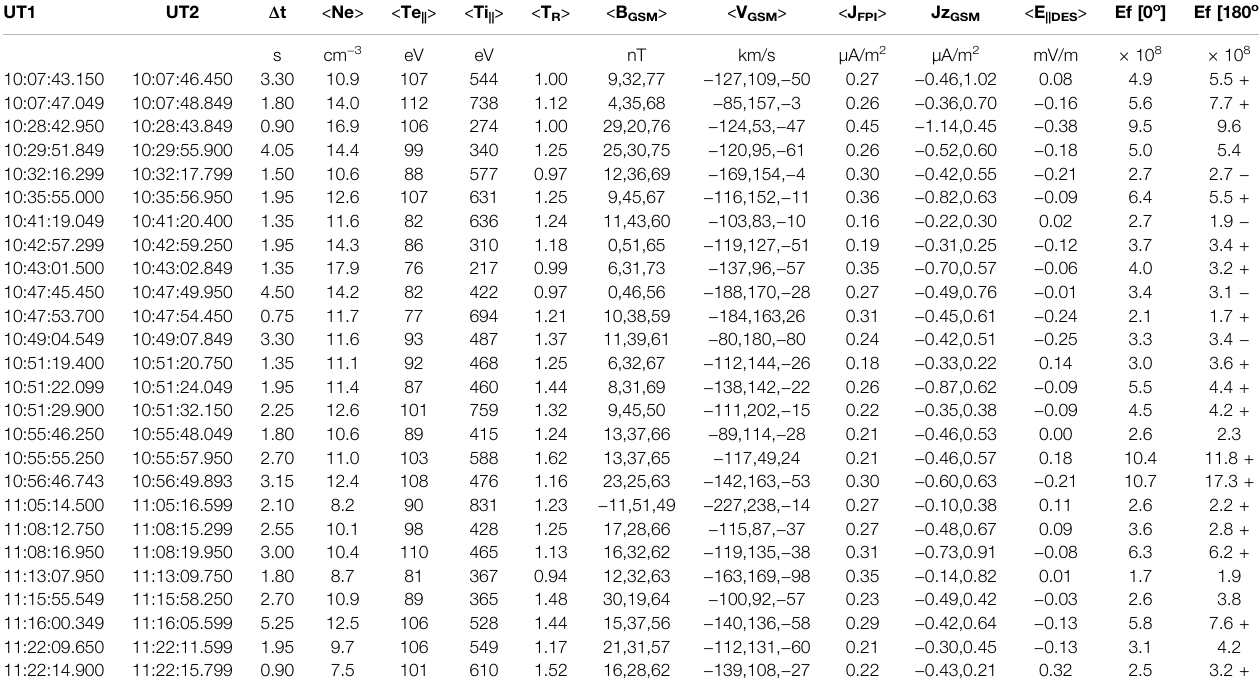
TABLE1| TimeperiodswhenMMS-1observedtwodistinct,counter-streamingionbeamsinacontinuousseriesofDISmeasurementsofionVDFs,superposedonaslowly drifting core of cold magnetosheath